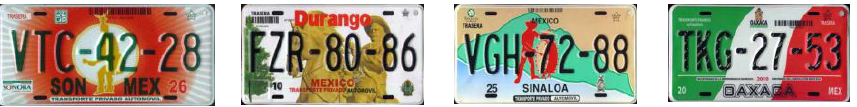
Figure 9. LP images with noise, blur, shadow and various illumination conditions.